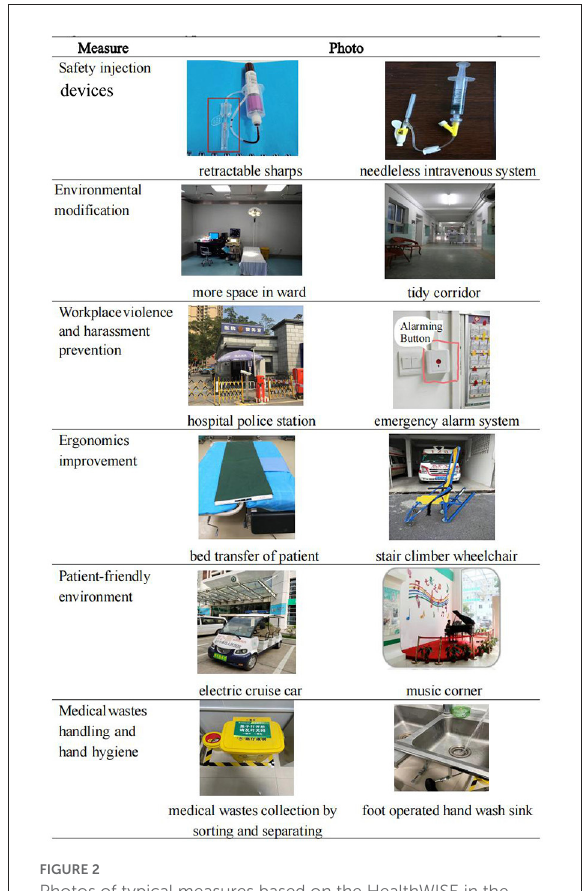
FIGURE2 Photos of typical measures based on the HealthWISE in the